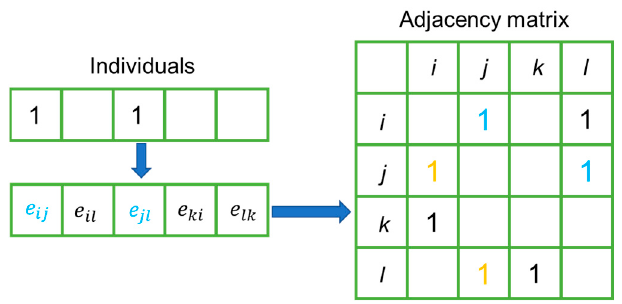
Figure 3. An illustration of the decoding process.